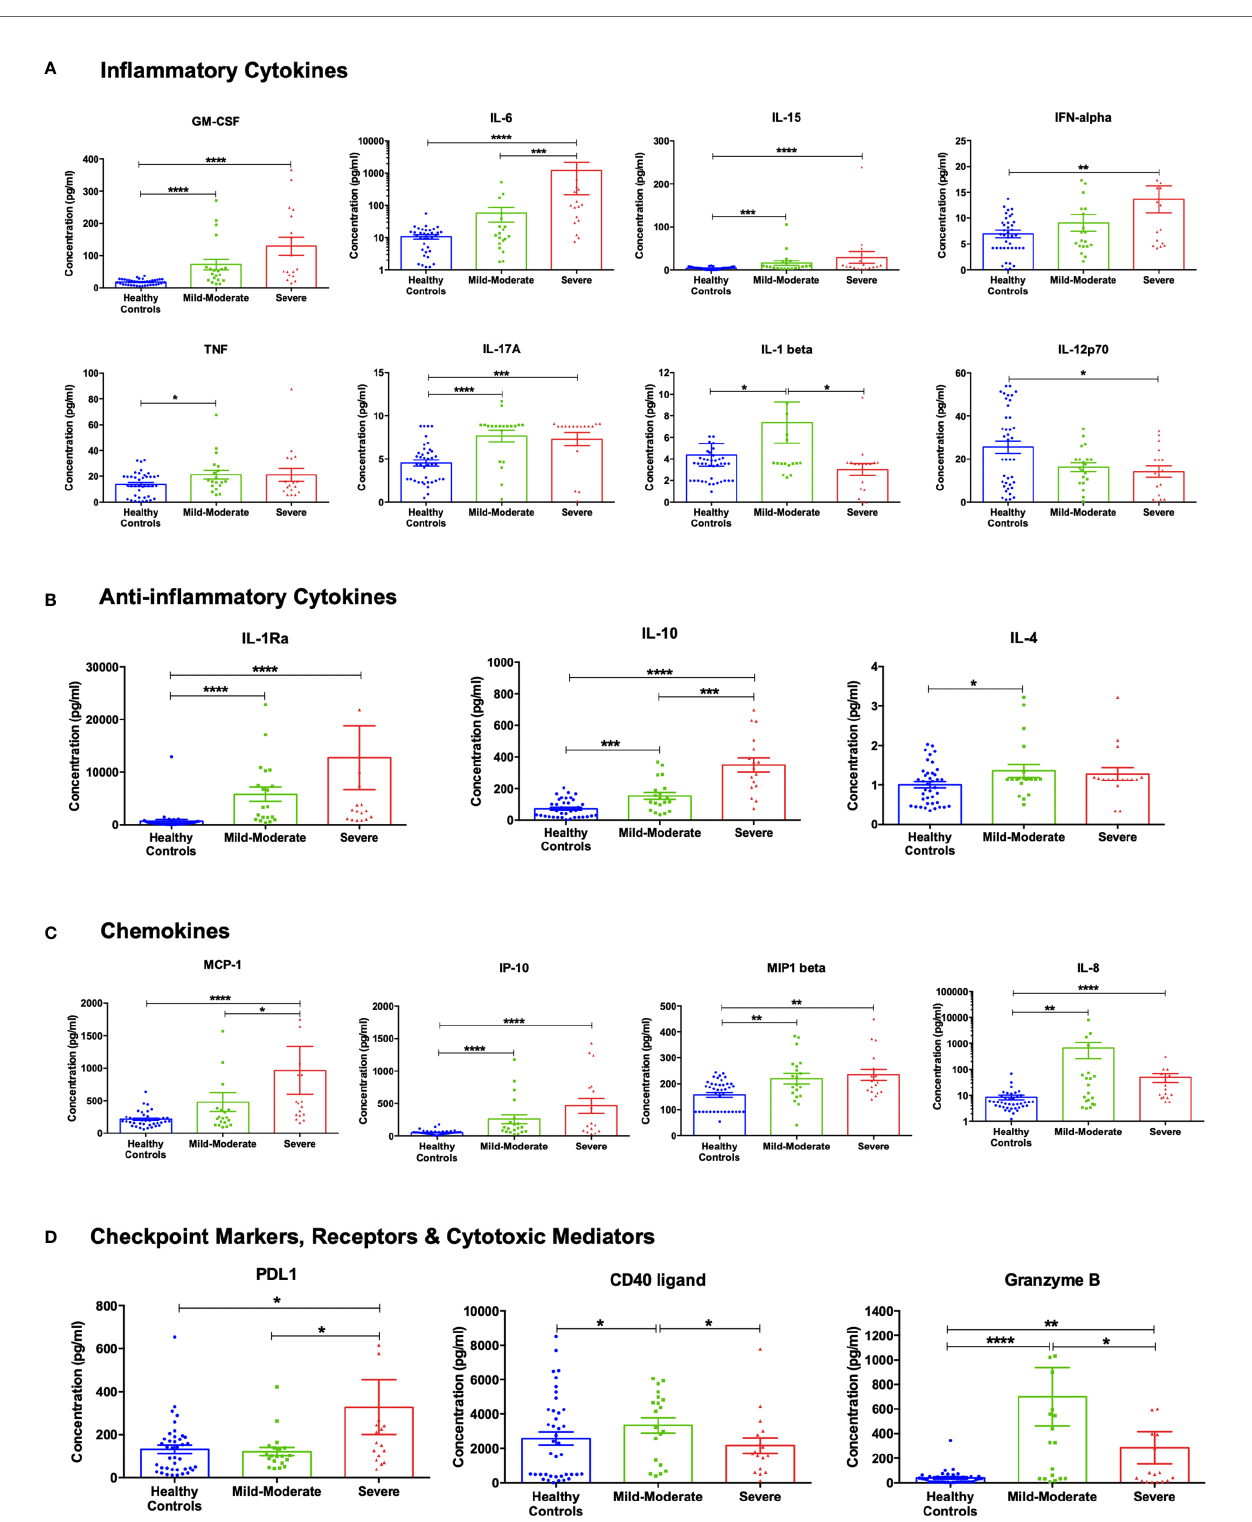
FIGURE 3 | Cytokine assessment in healthy control subjects (n =40), mild-moderate COVID-19 (n= 20) and severe COVID-19 (n=17) patients. (A) In fl ammatory, (B) anti- in fl ammatory cytokines, (C) chemokines, and (D) checkpoint markers, receptors and cytotoxic mediators were assessed in mild-moderate and severe COVID-19 patients and their levels compared to healthy controls. Data is expressed as mean ± standard error of mean (SEM). *p<0.05, ** p<0.01, ***p<0.001, and ****